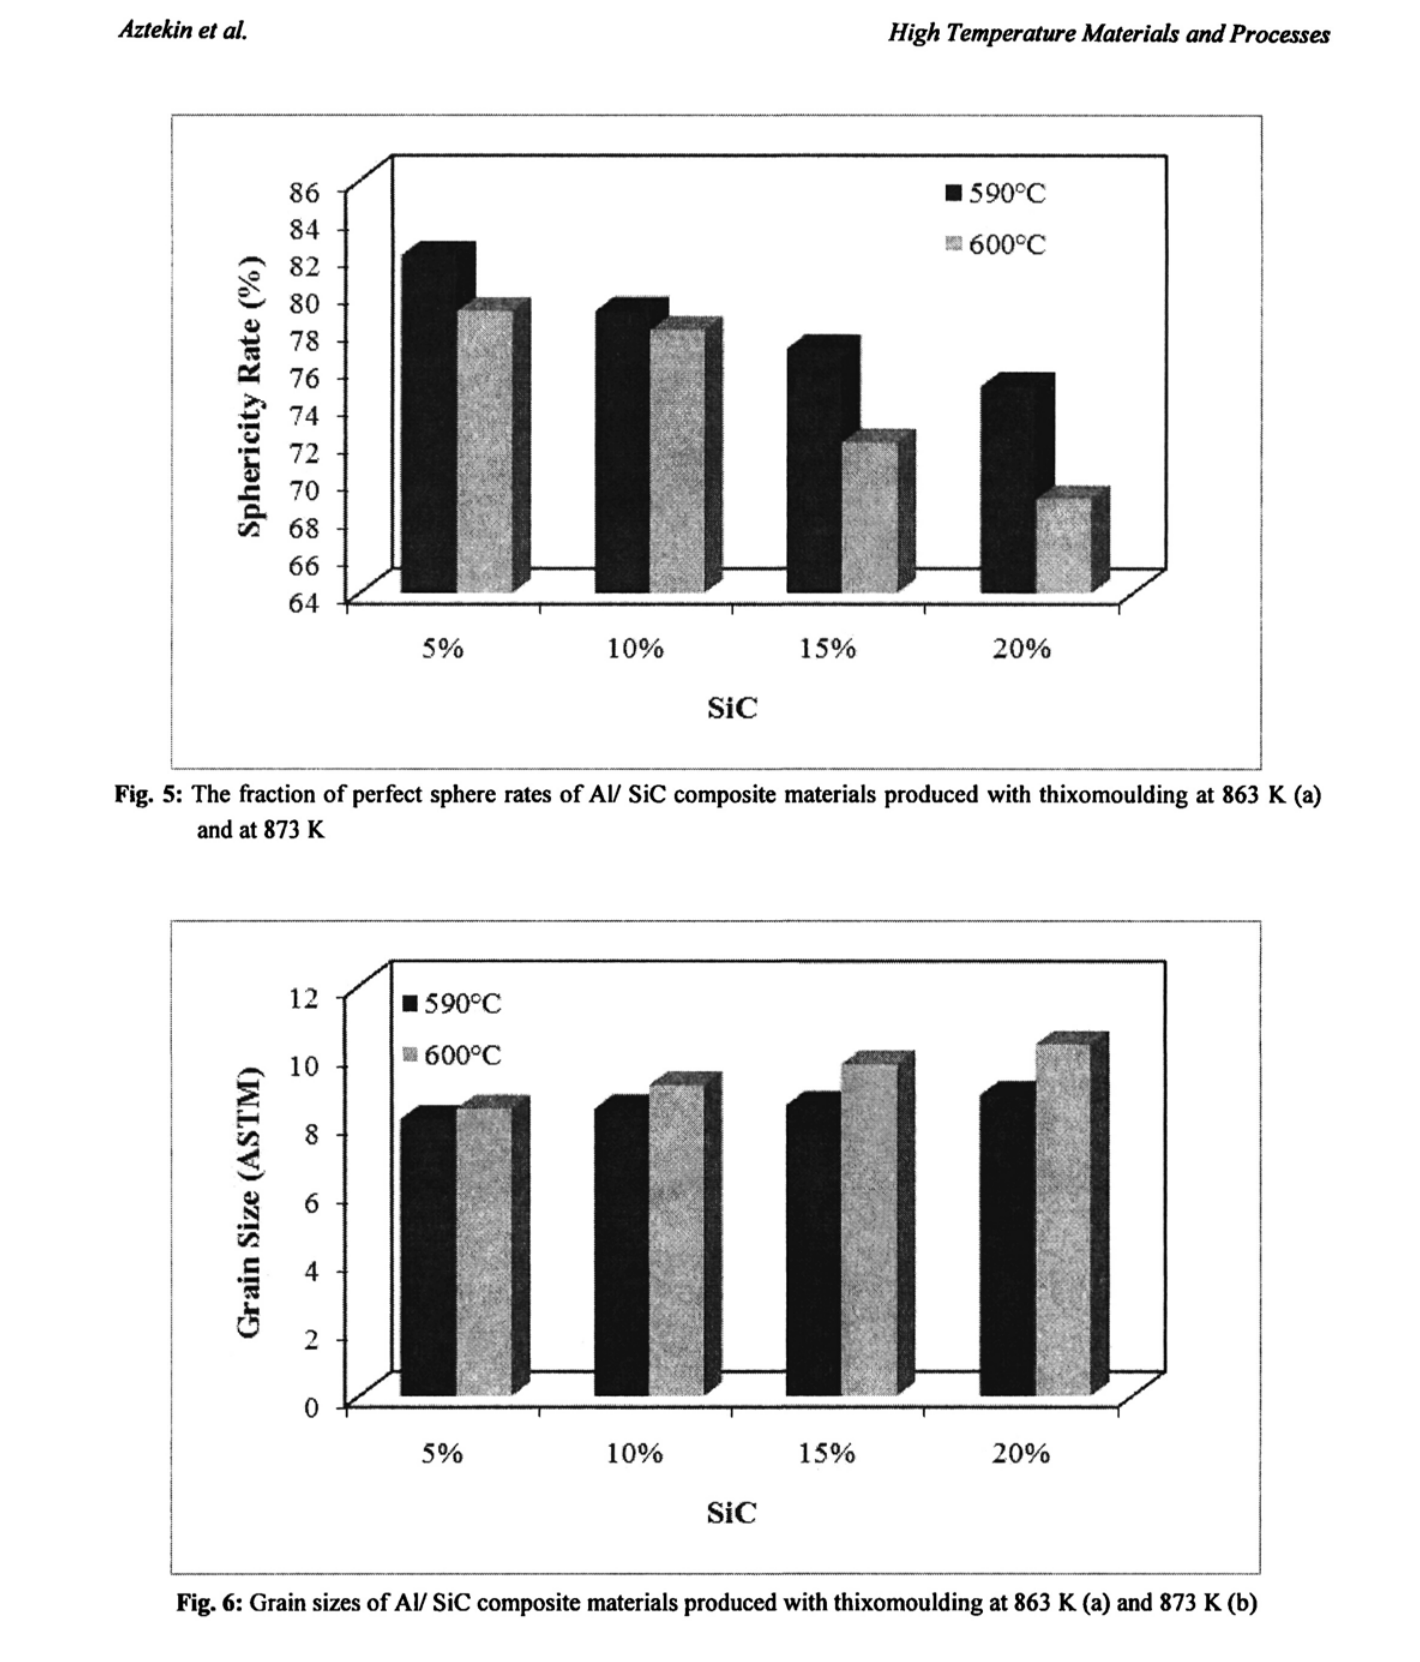
Fig. 6: Grain sizes of Al/ SiC composite materials produced with thixomoulding at 863 K (a) and 873 K (b)